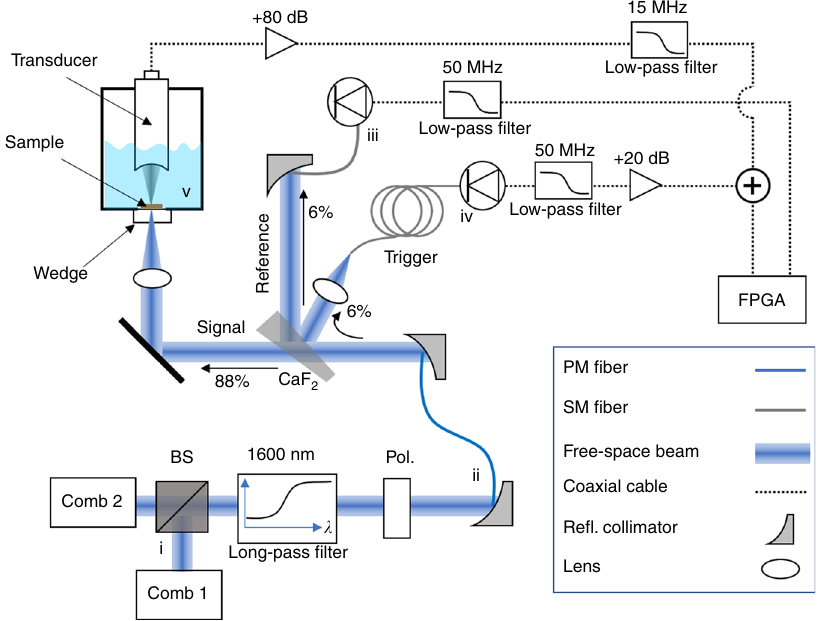
Fig. 2 Experimental setup for dual-comb photoacoustic spectroscopy. Two frequency combs (lower left) are combined on a beam-splitter and fi ltered. The combined beam is focused onto a sample in a water bath (upper left). A focused ultrasound transducer measures the photoacoustic pressure waves emitted by the sample when it absorbs light. The transducer output is ampli fi ed and fi ltered before being digitized with a fi eld-programmable gate array (FPGA). Approximately 6% of the combined beam is picked off by a calcium- fl uoride wedge (center) and used as a reference signal. Another 6% of the beam is used for triggering the data acquisition system (right-center). Additional details are discussed in the methods